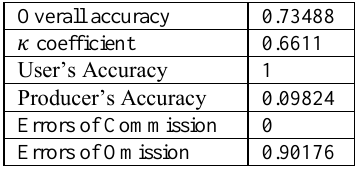
Table 4: Accuracy